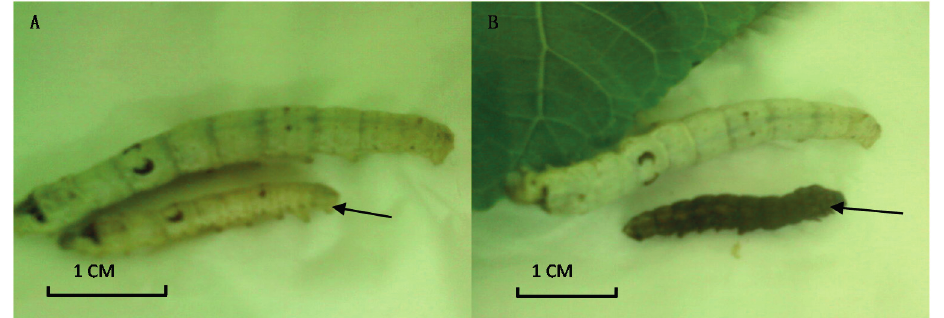
Figure 7. Growth inhibition of dsRNA-treated larvae. ( A ) The growth retardation compared with the control at 10 days after injection; and ( B ) The RNAi-treated silkworm in black body color at 10 days after